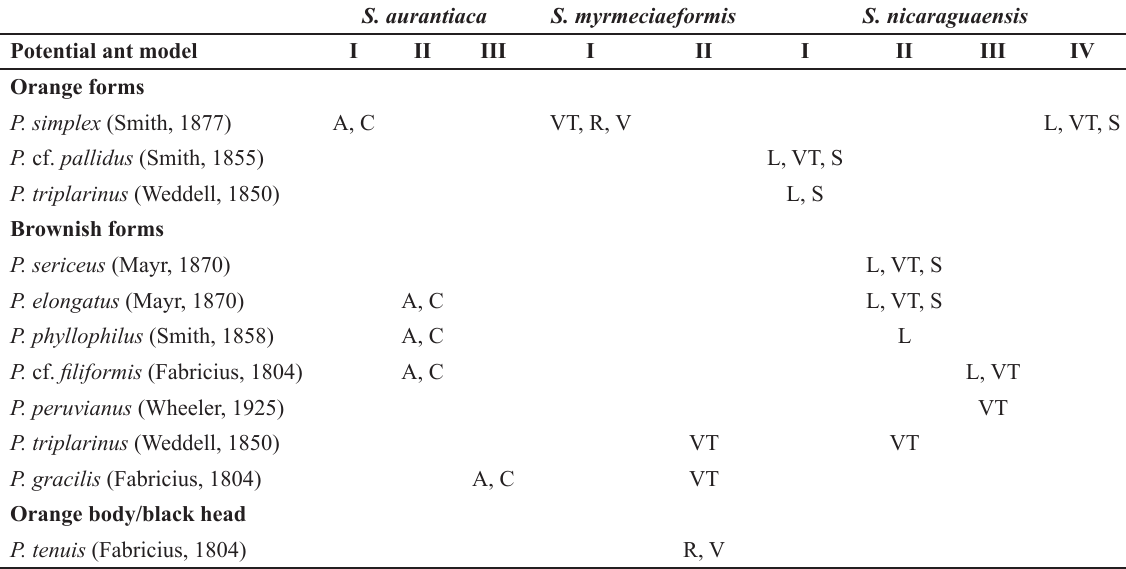
Table 1. Co-occurrence pattern of Bolivian Synemosyna Hentz, 1846 species and potential model species of Pseudomyrmex Lund, 1831 (only localities with a sample size higher than n = 12 were considered): S. aurantiaca (Mello-Leitão, 1917) (I) 2.5–5.5 mm (orange-reddish); (II) 4.6–6.4 mm (light brown); (III) 5.8–7.0 mm (dark brown/blackish); S. myrmeciaeformis (Taczanowski, 1871) (I) 3.1–6.7 mm (orange); (II) 6.0–8.0 mm (dark brown or orange with black cephalic part); S. nicaraguaensis Cutler, 1993 (I) male 2.65–5.85 mm (orange-reddish); (II) male 3.45–5.85 mm (brownish); (III) male 3.84–5.05 mm (orange carapace and blackish abdomen); (IV) female 3.45–5.2 mm (orange). Abbreviations: A = Arambulo; C = Cotoca; L = La Guardia; S = Santa María La Antigua; V = Villa Tunari; VT = Villa Teresa. Please note that orange and brown forms of Pseudomyrmex triplarinus (Weddell, 1850) were observed. Body length of Pseudomyrmex spp.: P. simplex (Smith, 1877) BL 3.7–4.5 mm; P . cf. pallidus (Smith, 1855) BL 3.3-3.95 mm; P. triplarinus (Weddell, 1850) (BL 4.8–6.7 mm); P. sericeus (Mayr, 1870) BL 4.4– 5.05 mm; P. elongatus (Mayr, 1870) BL 2.9–3.8 mm; P. phyllophilus (Smith, 1858) BL 4.9–5.1 mm; P . cf. filiformis (Fabricius, 1804) BL 4.6–5.2 mm; P. peruvianus (Wheeler, 1925) (BL 3.0–3.5 mm); P. gracilis (Fabricius, 1804) BL 6.7–11.0 mm; P. tenuis (Fabricius, 1804) BL 5.3–7.0